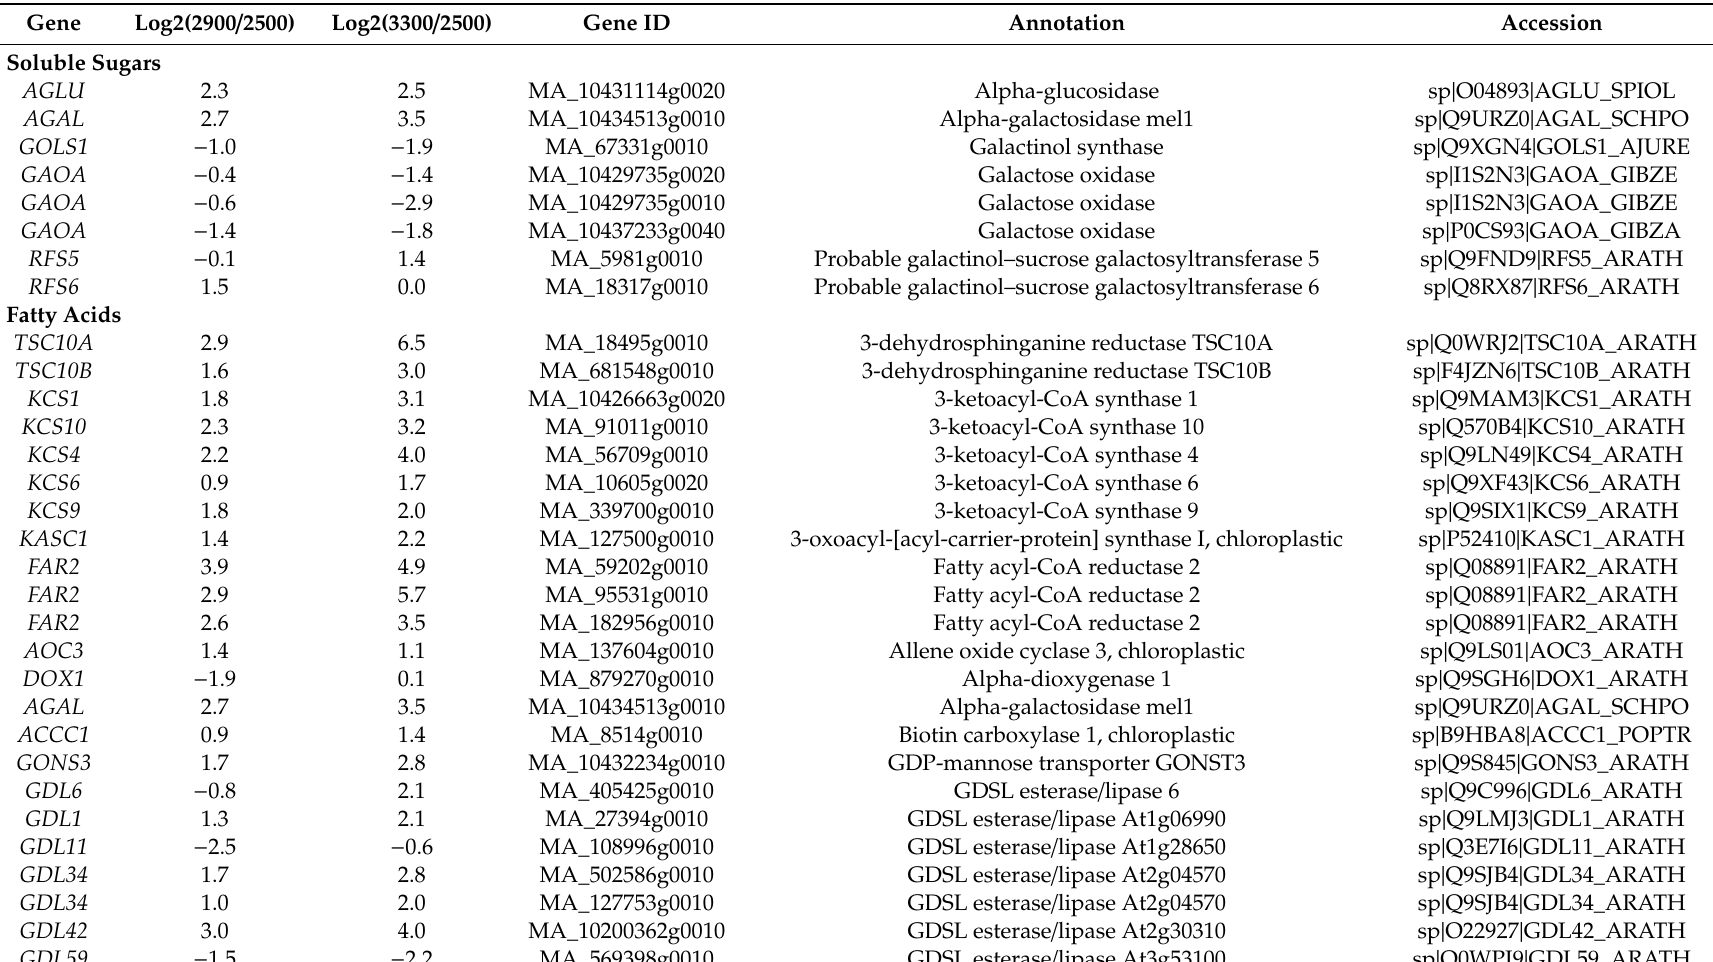
Table 2. DEGs involved in non-structural carbon